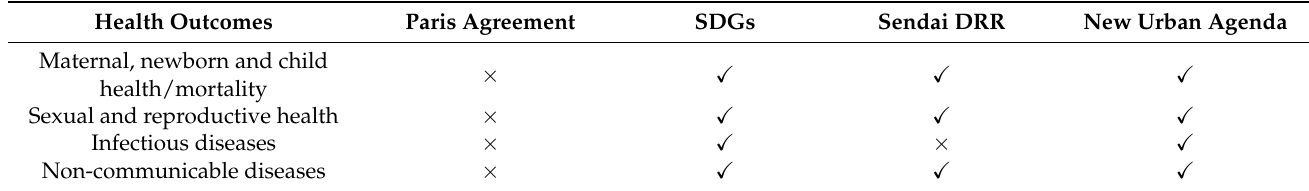
Table 3. Analysis of health outcomes across all four agreements.